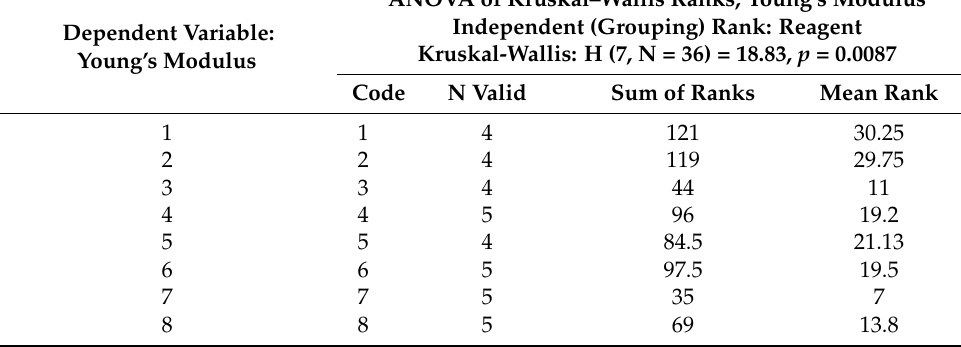
Table 4. Results of the Kruskal–Wallis